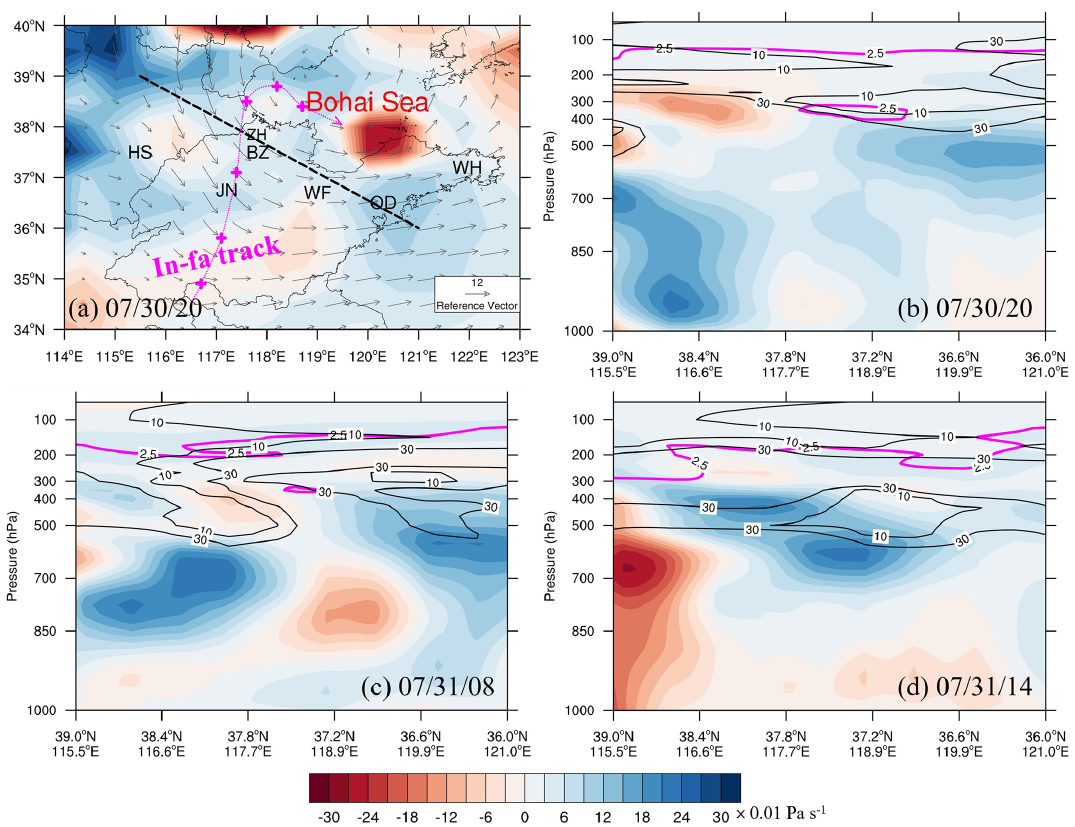
Figure 5. (a) Vertical velocity (shaded; 0.01Pas − 1 ) at 700hPa overlaid with 850hPa horizontal wind flows (gray vector; reference vector is 12ms − 1 ) at 20:00 LST on 30 July 2021. The magenta crosses represent the tracks of Typhoon In-fa during its dissipation stage, with a time interval of 6 h. (b–d) Cross sections of vertical velocity (shaded; unit: 0.01Pas − 1 ; the positive values represent the downward air motions and the negative values represent the upward air motions), relative humidity (solid black lines with values of 10% and 30%) and the 2.5PVU dynamical tropopause height (solid magenta lines) at 20:00 LST on 30 July (b) , 08:00 LST on 31 July (c) , and 14:00 LST on 31 July 2021 (d) . The time in (b) – (d) is indicated as month/day/hour at the bottom right corners. The cross sections are performed along the dashed black line in Fig.